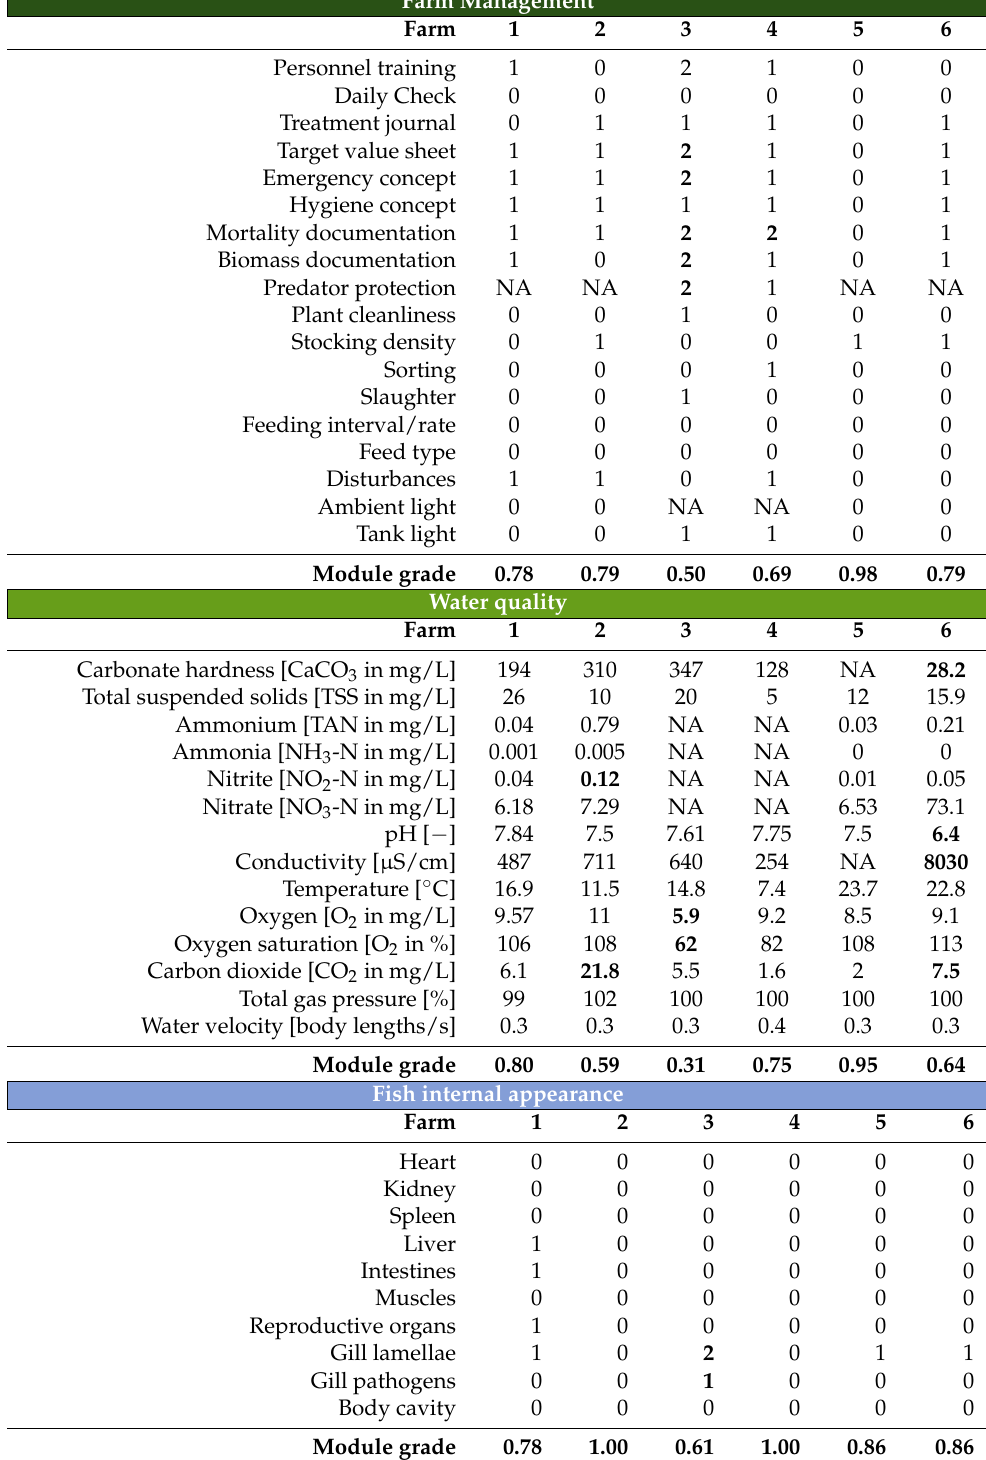
Table 3. On-site farm testing results using the MyFishCheck model with the final module grades. For the module water quality , the parameter values were presented; for the modules farm management, fish group behaviour, fish external appearance and fish internal appearance, the parameter intervals are given. Parameters mainly responsible for lower module grades are given in bold. NA = data not available as the parameter does not apply in this location or